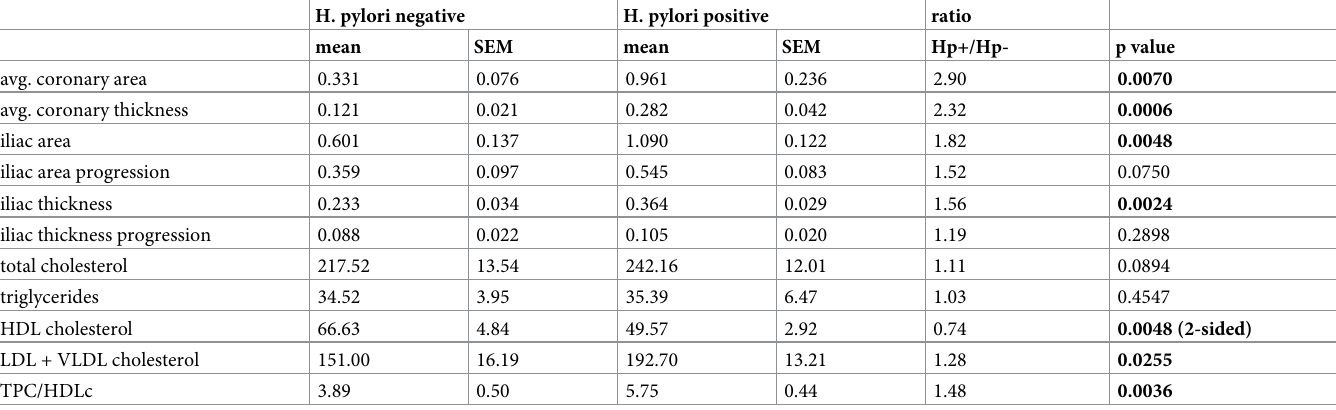
Table 2. Postmenopausal plaque measurements and lipid profiles.